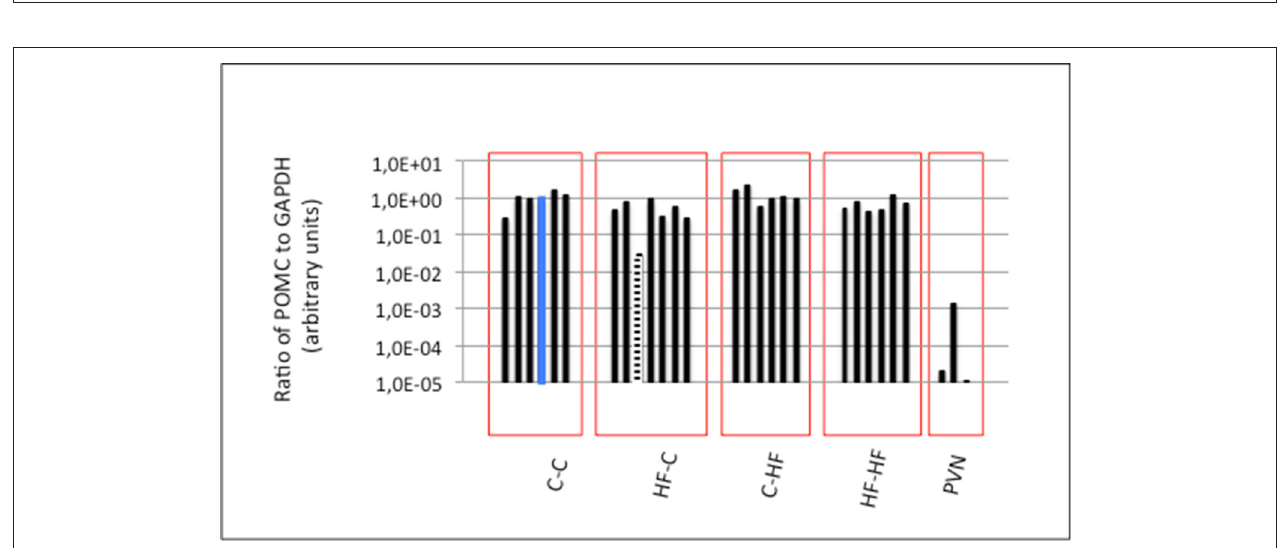
FIGURE 2 | ARC molecular characterization. The ARC harbors a neuronal population specifically expressing POMC transcripts when compared to the surrounding hypothalamic nuclei including the PVN. GAPDH and POMC expression were analyzed by RT-qPCR. POMC expression was normalized to GAPDH expression in each ARC and PVN. Ratio in one ARC of Group C-C (blue bar) was taken as the reference ratio. Ratios are shown using a log 10 scale. All ARCs displayed POMC to GAPDH ratios at least a hundred-fold higher than those characterizing the PVNs except one ARC of Group HF-C (hatched bar) that was excluded from further analyses. Twenty-four ARCs (six ARCs/group) were conserved for analyses of miRNA